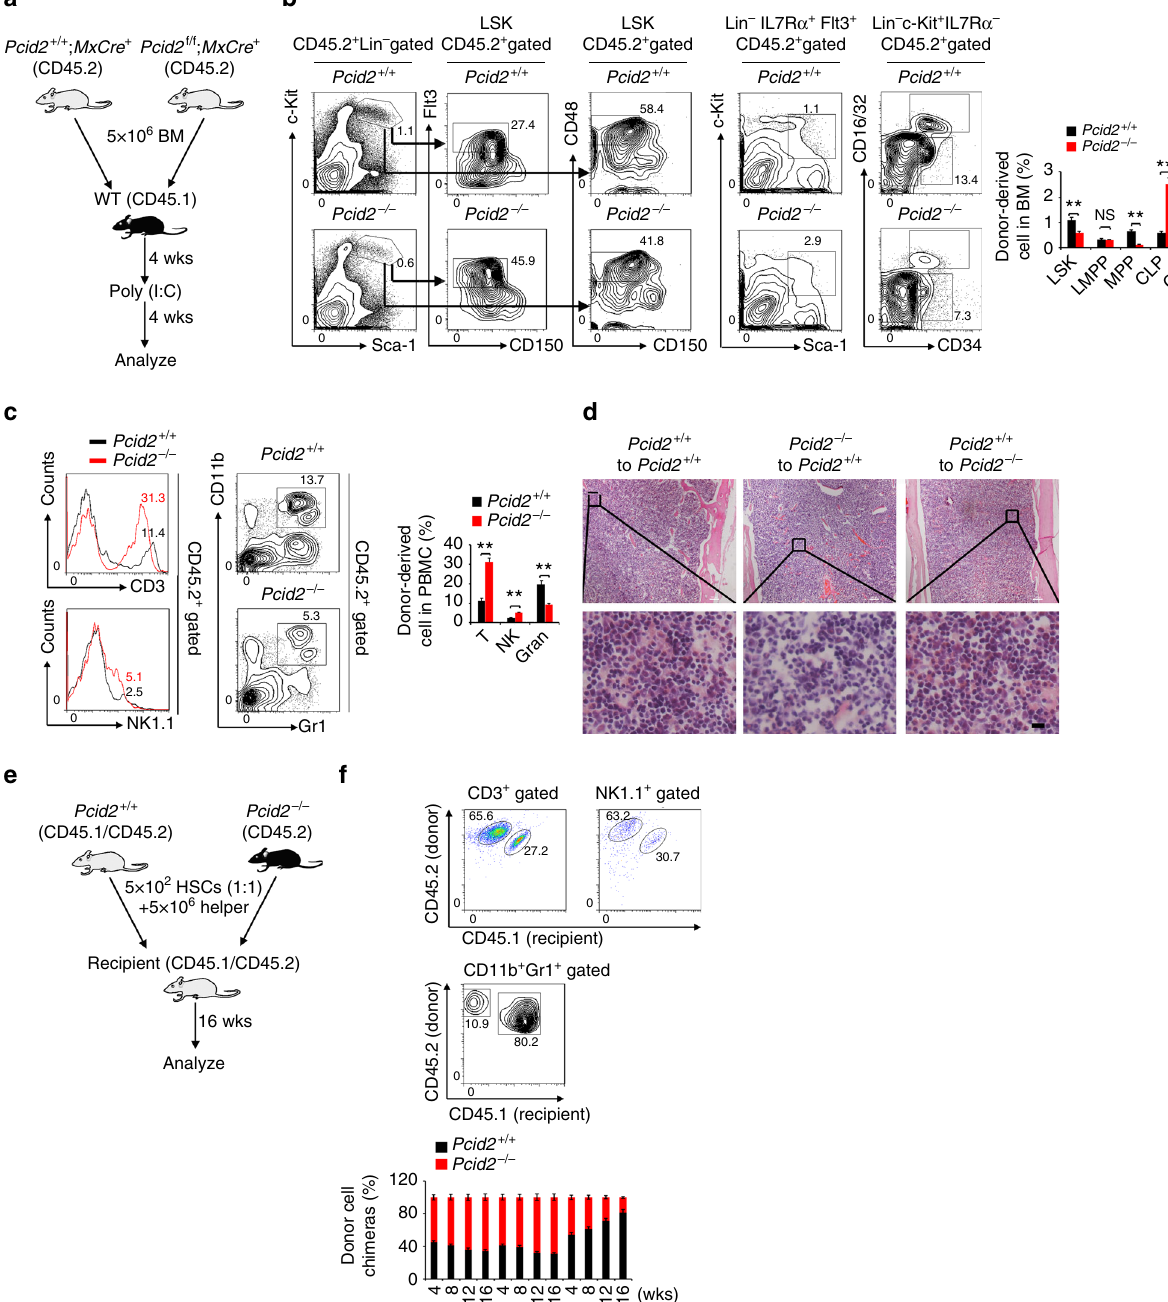
Recipient (CD45.1/CD45.2)